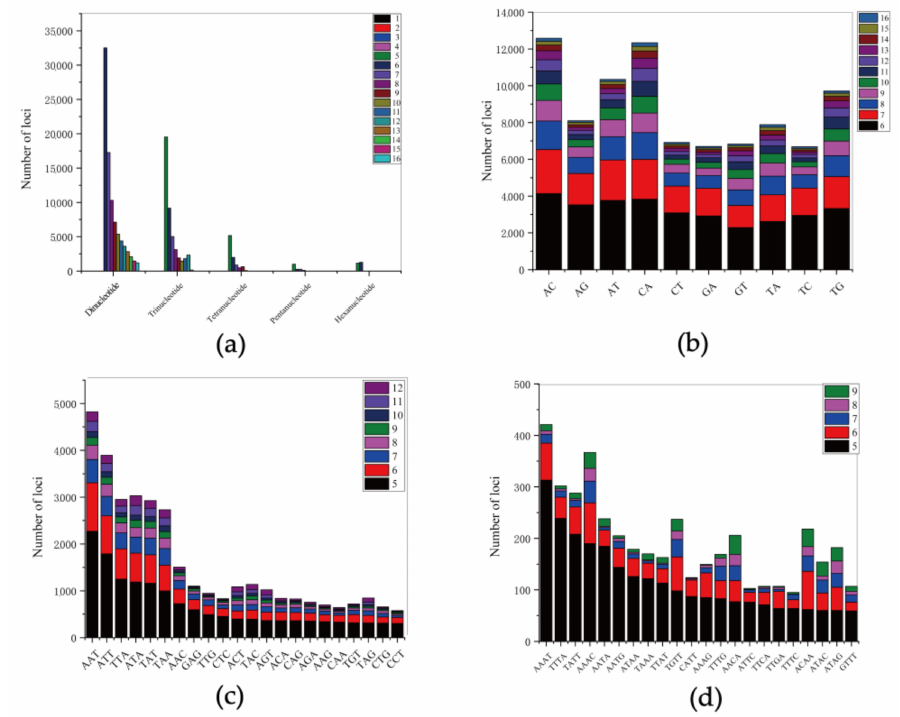
Figure 5. The distribution and frequency of microsatellite motifs in the shimofuri goby: ( a ) fre- quency of different microsatellite repeat types; ( b ) frequency of different dinucleotide microsatellite motifs; ( c ) frequency of different trinucleotide microsatellite motifs; and ( d ) frequency of different tetranucleotide microsatellite